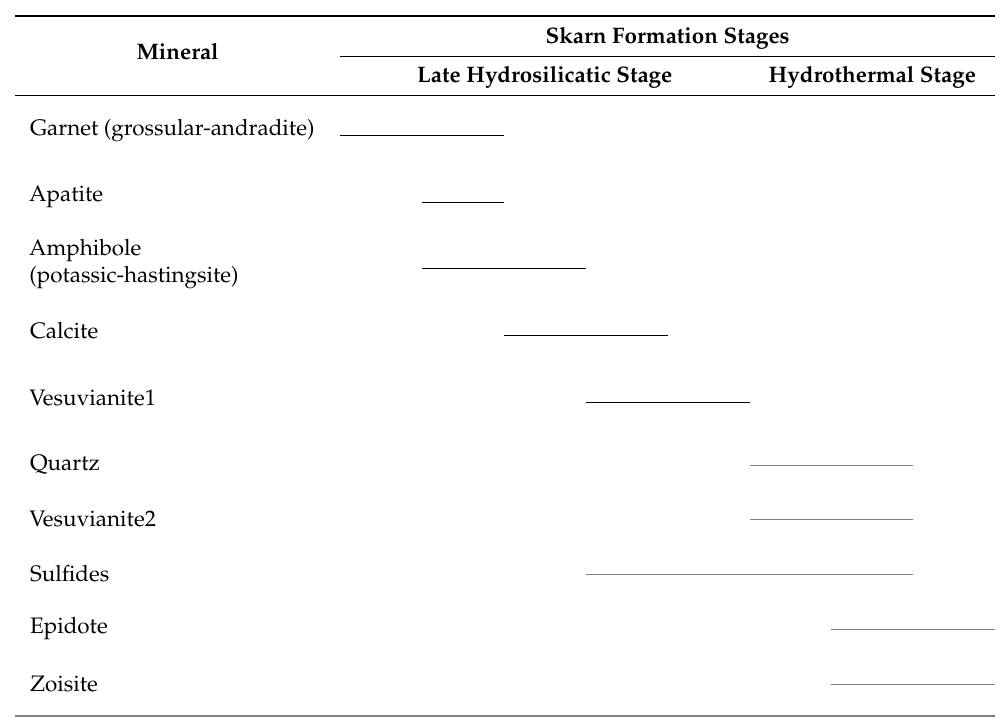
Table 3. Schematic diagram showing paragenetic relationships of mineral assemblages in the skarn sample, based on paragenetic relation and microtextural